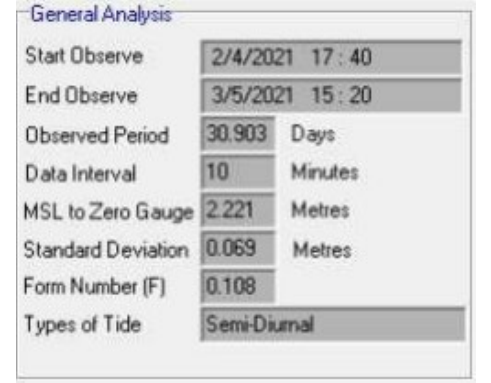
Figure 7. General analysis of tidal analysis at the project area